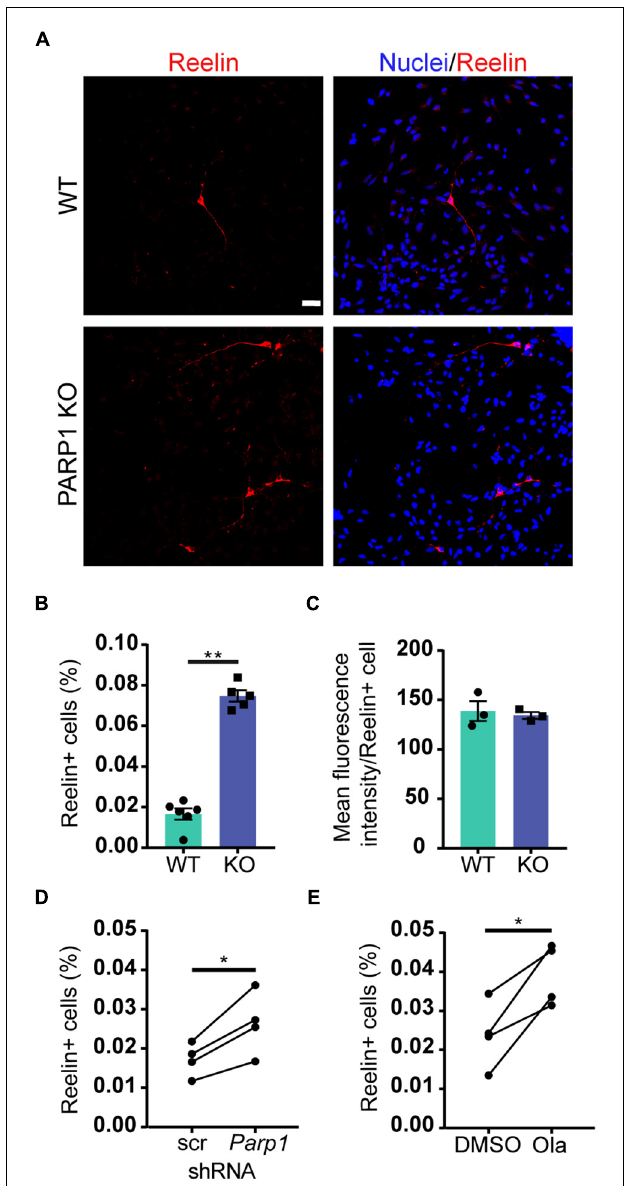
FIGURE 6 | Poly (ADP-ribose) polymerase 1 loss increases CR cell abundance in NPC cultures. (A) Immunostaining for Reelin (red) demonstrates presence of Reelin-expressing cells in WT and PARP1 KO NPC cultures. Nuclei were labeled with DAPI (blue). Scale bar, 20 µ m. (B) Quantification of the percentage of Reelin-expressing cells within NPC cultures shows increased proportion of Reelin+ cells in KO cultures ( n = 6 WT and 5 KO biological replicates and 3 coverslips per replicate). ** p = 0.0013 by Mann–Whitney test. (C) The mean fluorescence intensity of Reelin expression per cell does not differ between genotypes. Each point on graph represents average Reelin intensity per cell from three biological replicates of each genotype. (D) The percentage of Reelin-expressing cells in wild-type NPC cultures increases after shRNA-mediated PARP1 knockdown for 72 h ( n = 4 biological replicates per group and 3 coverslips per replicate). * p = 0.0174 by Student’s paired t -test. (E) The percentage of Reelin-expressing cells in wild-type NPC cultures increases with PARP1 inhibition via Olaparib (50 nM) for 72 h. Olaparib was re-treated every 24 h ( n = 4 biological replicates per group and 3 coverslips per replicate). * p = 0.022 by Student’s paired t